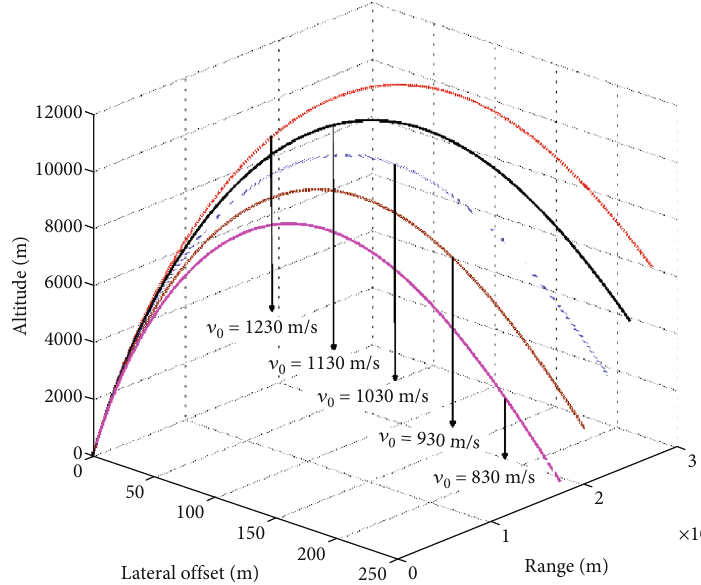
Figure 2: Trajectory curves at di ff erent initial